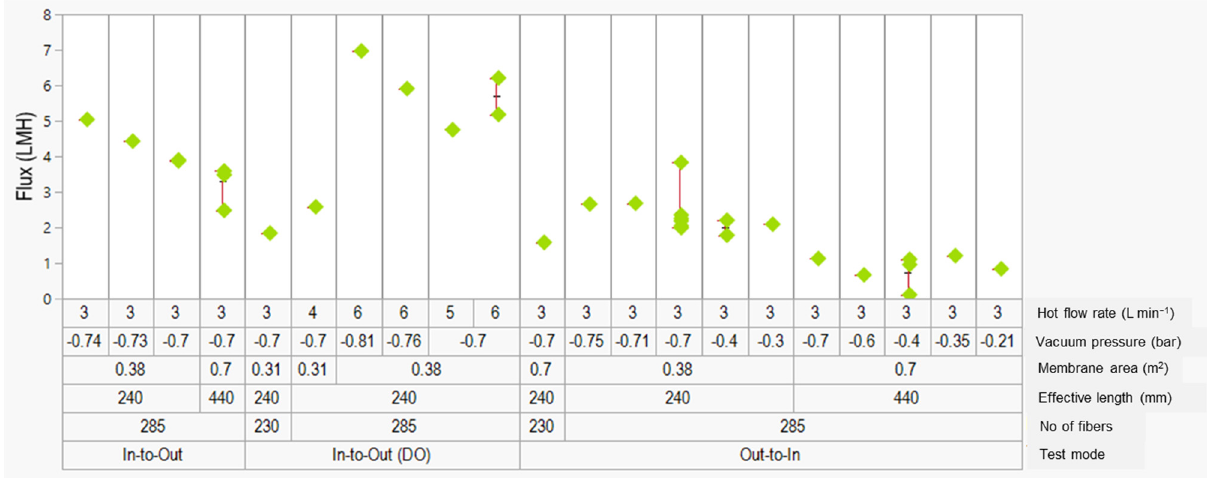
Figure 8. Flux optimization data for the PVDF TBHF membranes under VMD mode with different module parameters and test conditions. The flux data are categorized into group 1 (in-to-out flow), group 2 (in-to-out double-outlet flow), and group 3 (out-to-in flow).